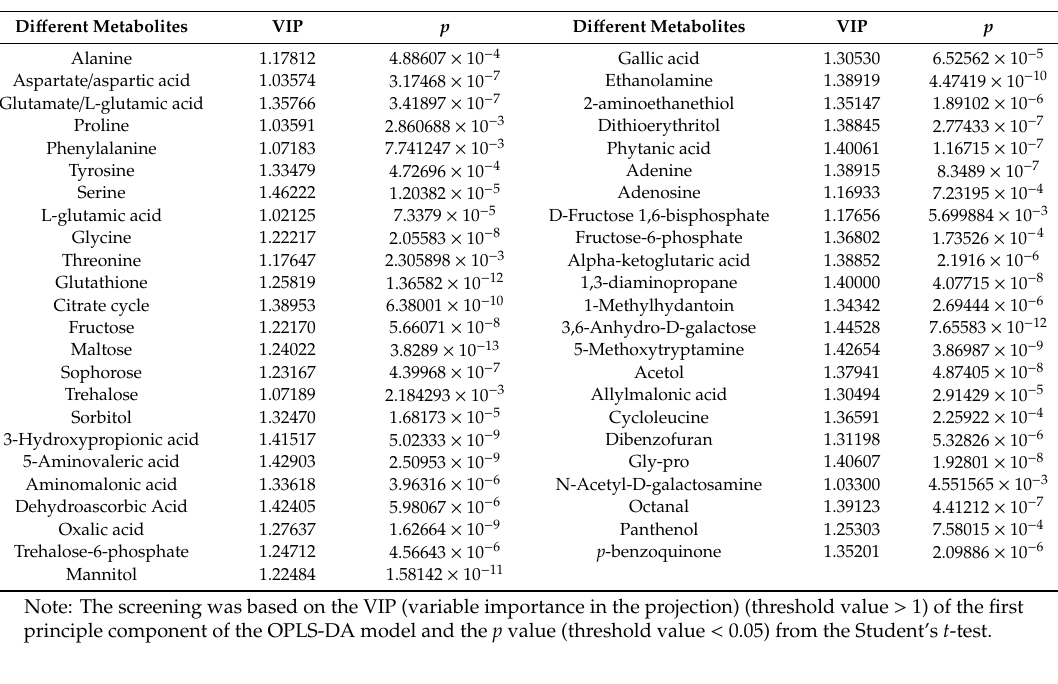
Table 1. Identification of di ff erent metabolites.